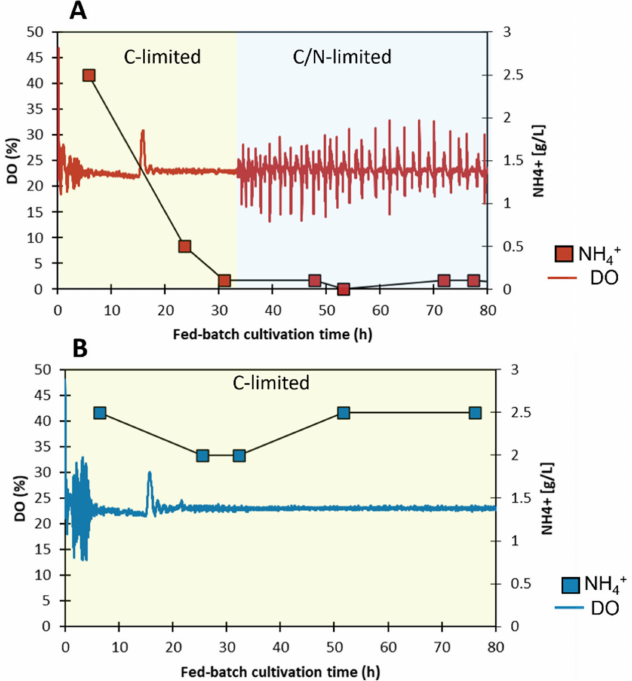
Figure 4. Baseline laboratory-scale fed-batch processes without CO 2 enrichment. ( A ) C/N-limited process. N-limitation began approximately 30 h after the feed started manifesting as low extracellular NH 4+ concentrations and metabolic oscillations in DO, pH, CO 2 , and other parameters. DO levels are presented as an example. The C-limited phase is marked with yellow and the dual C/N-limited phase with light blue. ( B ) Sole C-limitation was achieved by supplementation with ammonium sulfate. NH 4+ concentrations are shown with square